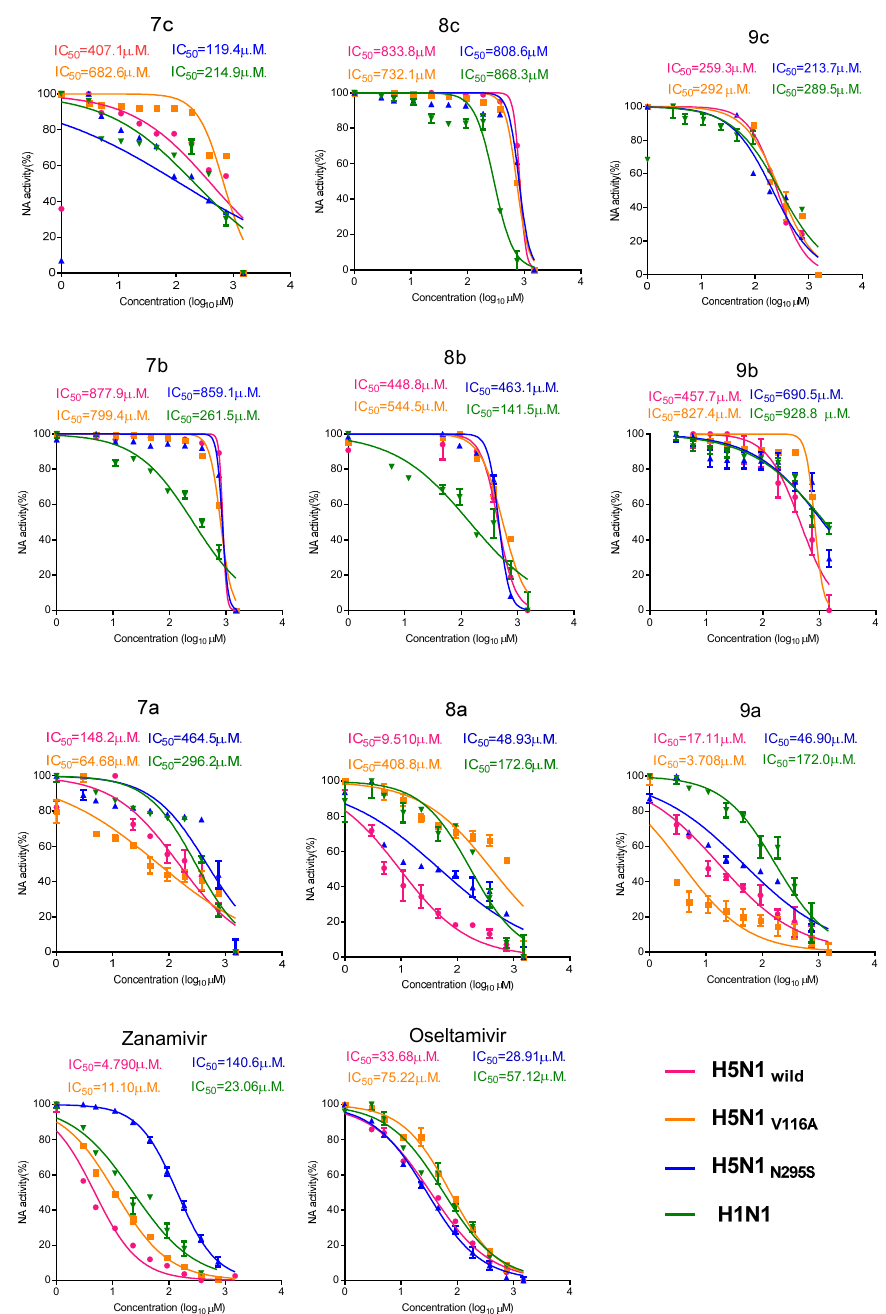
dose of 9c that affected aspartate aminotransferase (AST). Hence, a 20 mg/kg dose was used to determine the antiviral efficacy of the compounds.